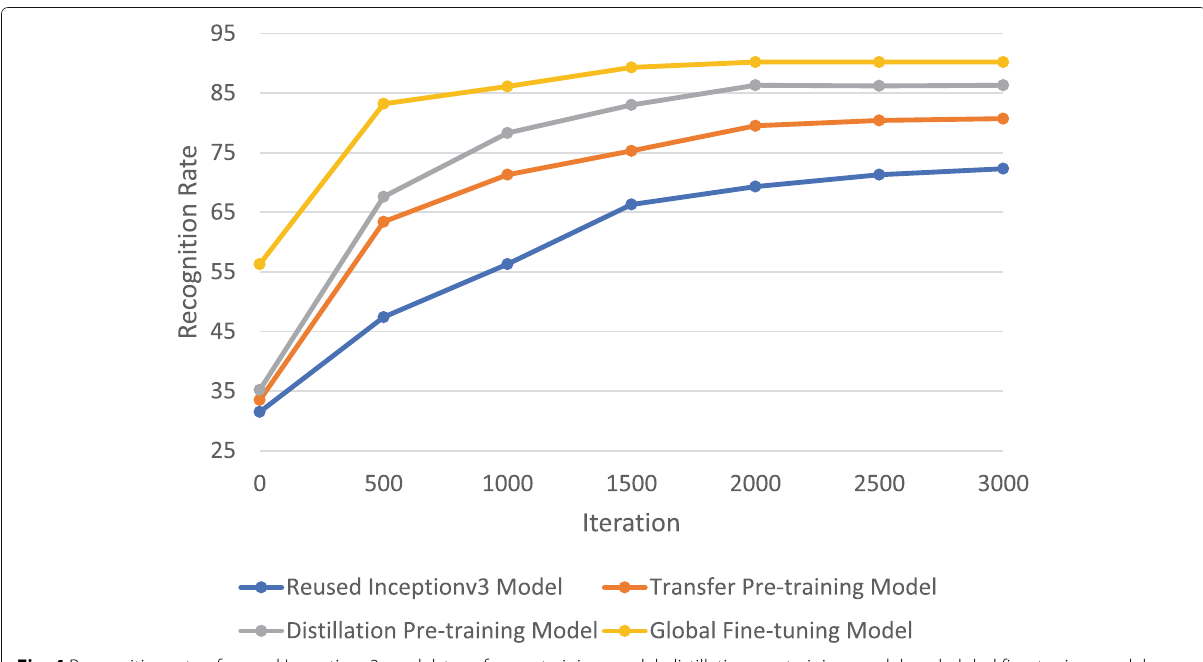
Fig. 4 Recognition rate of reused Inceptionv3 model, transfer pre-training model, distillation pre-training model, and global fine-tuning model